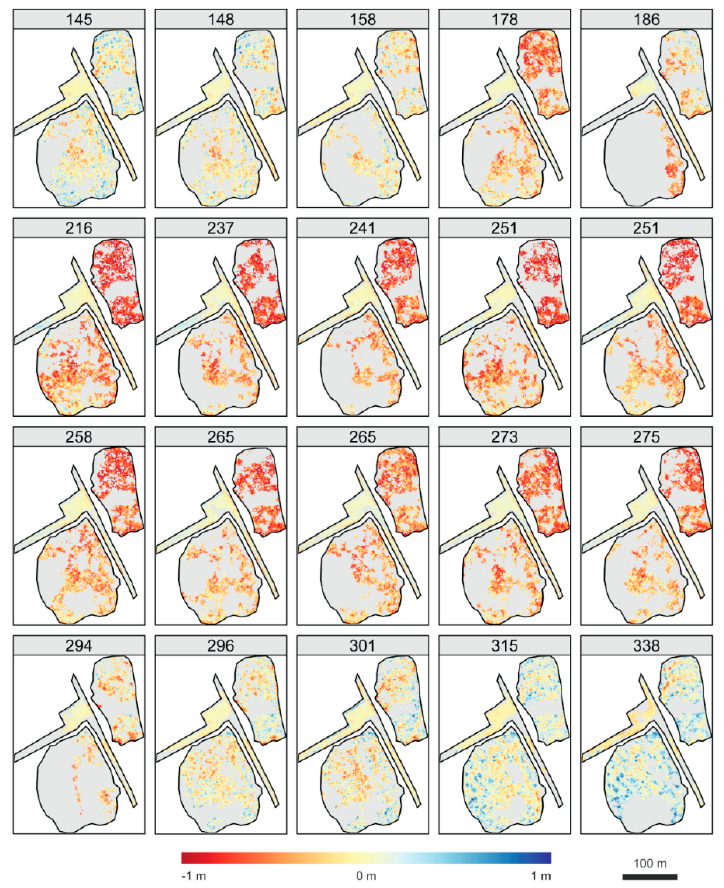
Figure 3. Visualized error (m) for each DAP-derived DTM listed by day of year relative to the reference ALS-derived DTM. Grey colour indicates the full extent of the reference DTM.